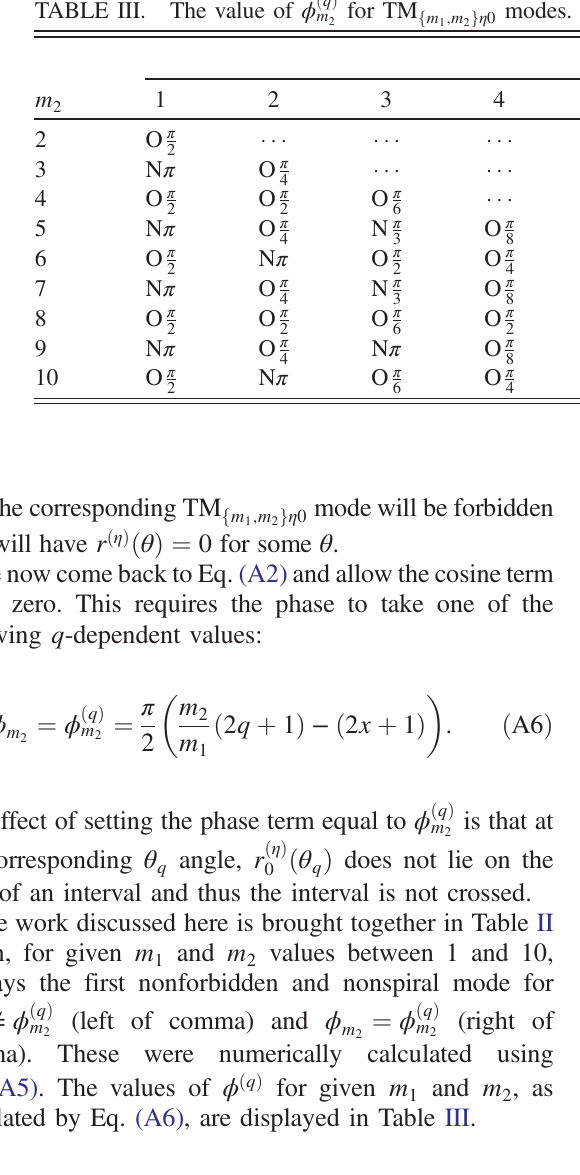
≠ ϕ ð q Þ m 2 (left of m 2